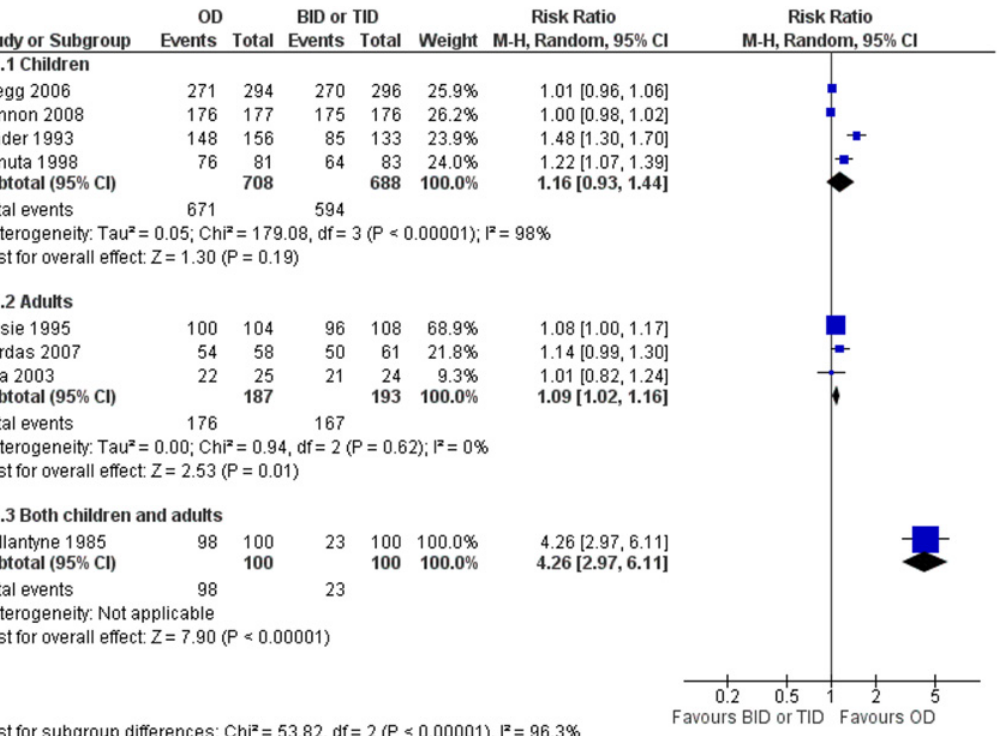
Figure 4. Forest plot depicting the risk ratios (RR) of compliance of patients receiving an antibiotic once-daily versus the same antibiotic or antibiotic of the same class twice or